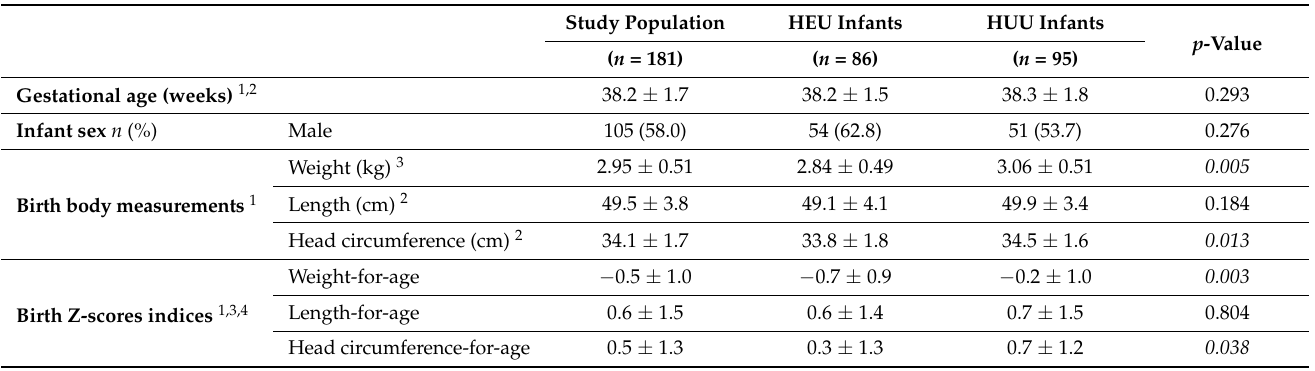
Table 2. Gestational age, sex, and anthropometric measurements and indices of HIV-exposed- uninfected and HIV-unexposed-uninfected infants at birth.